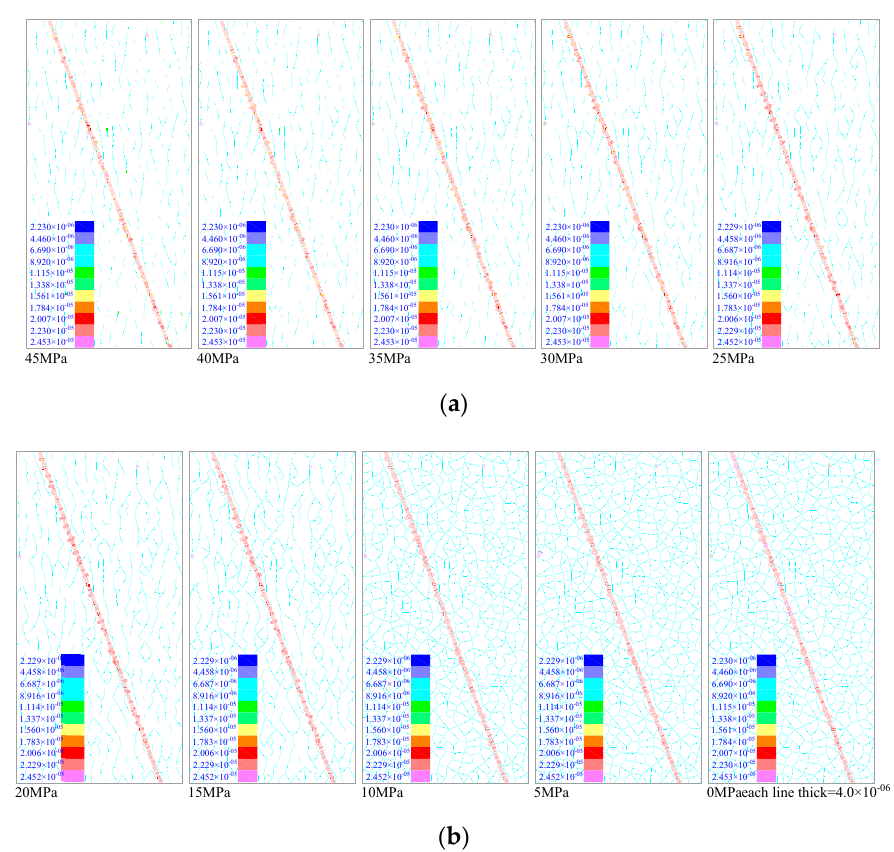
Figure 17. Joint hydraulic aperture values. ( a ) 45–25 MPa. ( b ) 20–0 MPa.